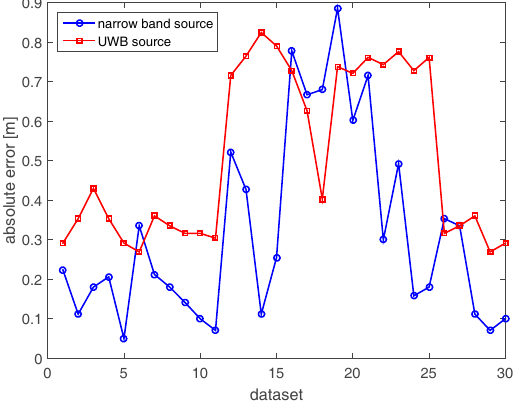
Figure 14. Positioning errors achieved with array data fusion (C).